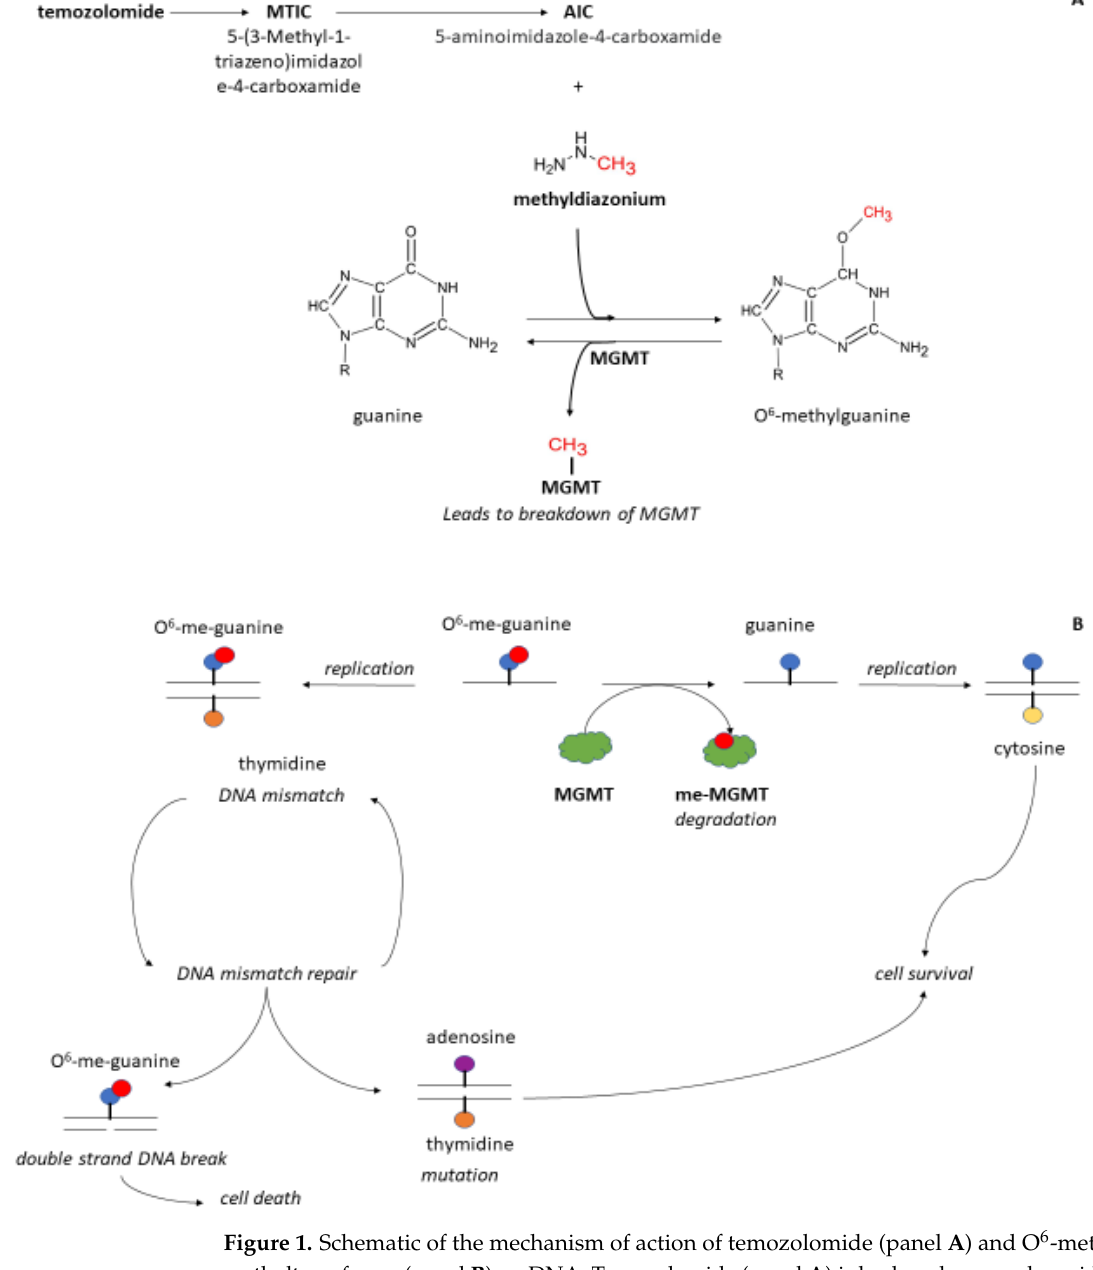
Figure 1. Schematic of the mechanism of action of temozolomide (panel A ) and O 6 -methyl-guanyl methyltransferase (panel B ) on DNA. Temozolomide (panel A ) is broken down under acid conditions (pH < 4) into 5-(3-Methyl-1-triazeno)imidazole-4-carboxamide (MITC). When pH raises in the gut (pH > 6) MITC is further converted into 5-aminoimidazole-4-carboxamide (AIC) and methyldiazonium. Methyldiazonum donates a methyl group to the O 6 -position of guanine resulting in DNA methylation. The enzyme methyl-guanyl methyl transferase (MGMT, panel B ) is a protein that can remove the added methyl group on guanine. Thereafter, MGMT is broken down and inactivated. When replication occurs, guanine pairs with cytosine. Upon methylation, O 6 -guanine is paired with